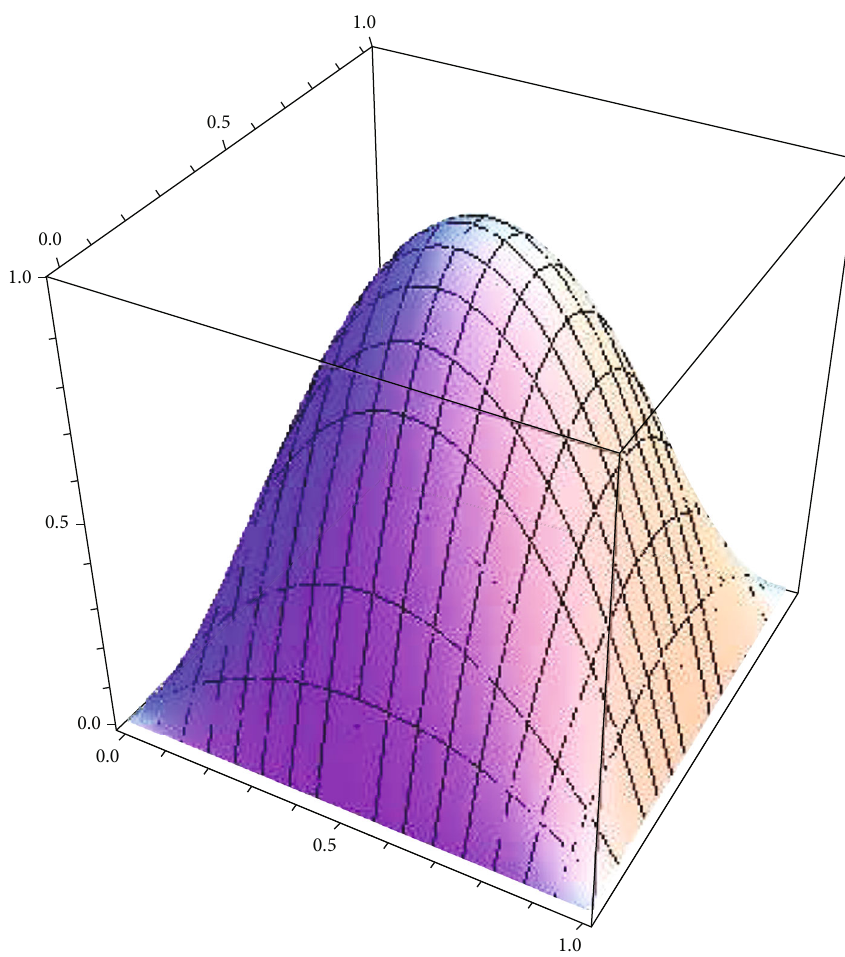
ð u , v Þ = ð u , v , 16 uv ð 1 − u Þð 1 − v ÞÞ for 0 ≤ u , v ≤ 1 . 0